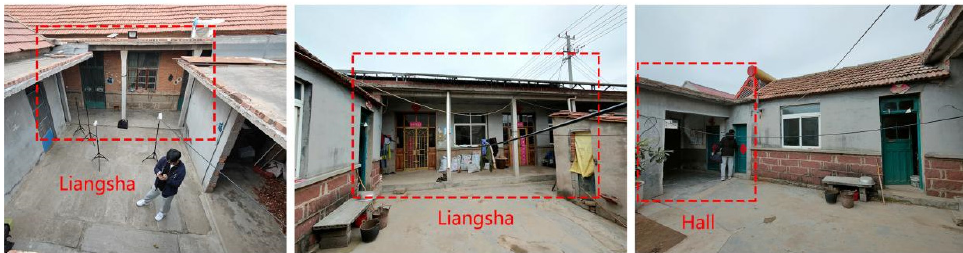
Figure 7. Site photos of vernacular dwelling.